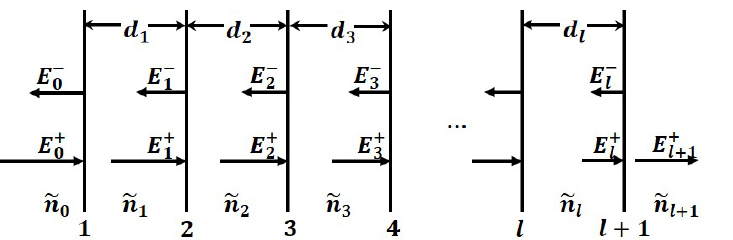
is the electricity vector of the incident light, and E − 0